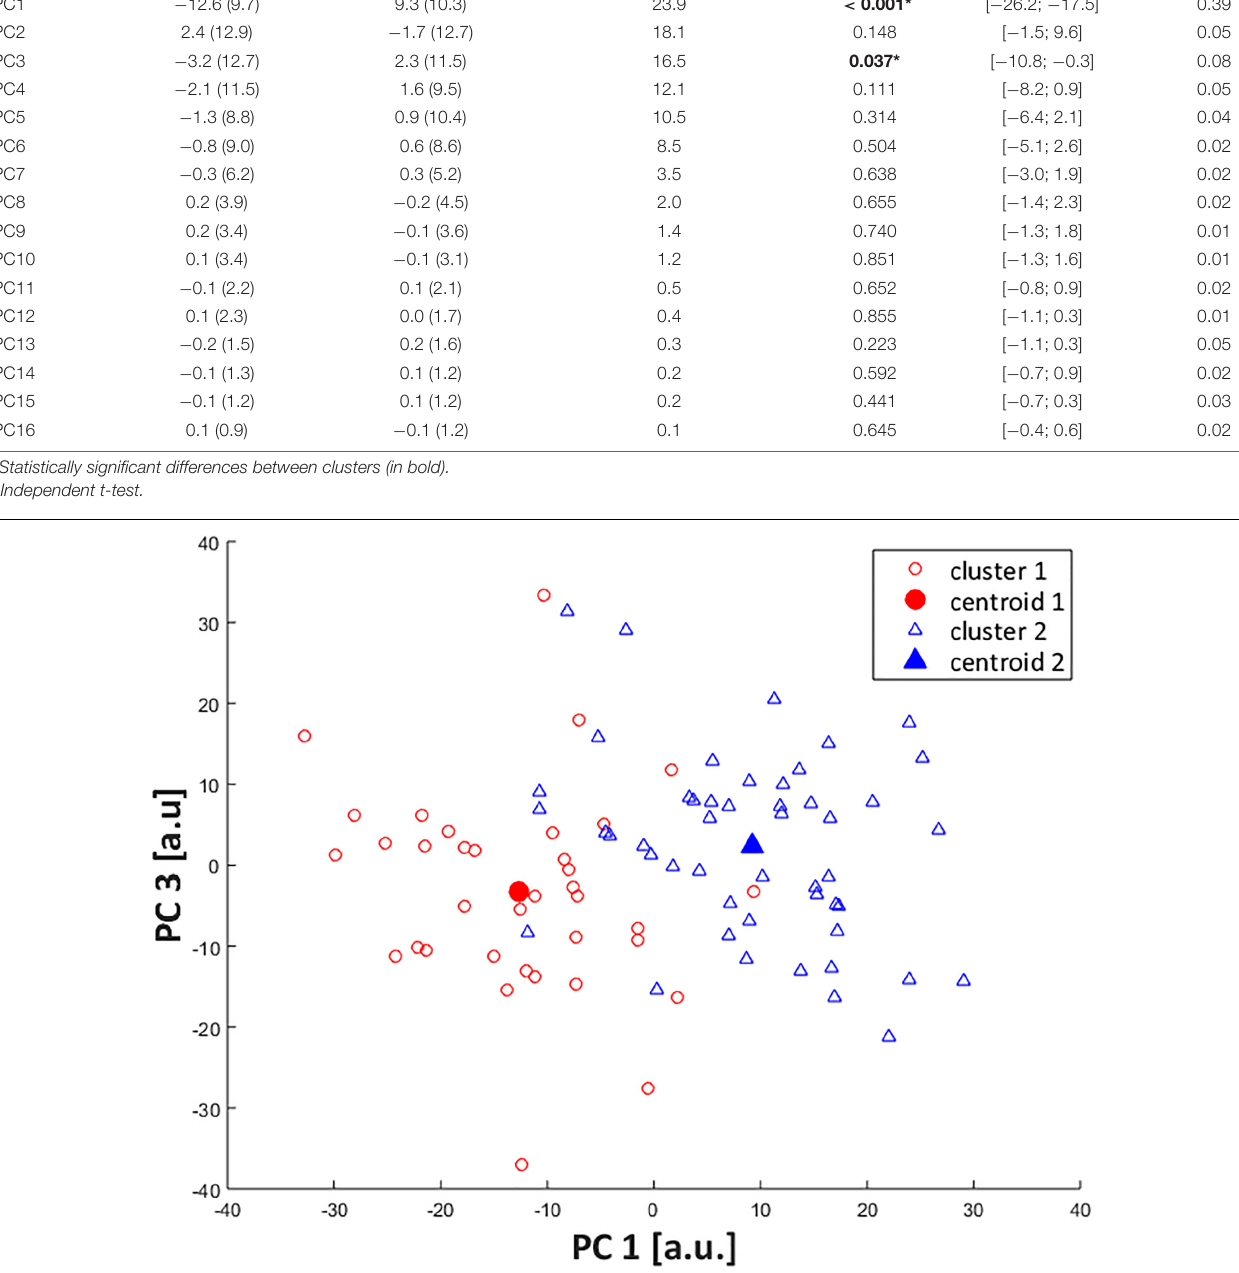
contained a greater level of variance explained, and showed a greater effect size in between-cluster differences ( Table 2 ), most of the observable differences between cluster 1 and 2 were related to